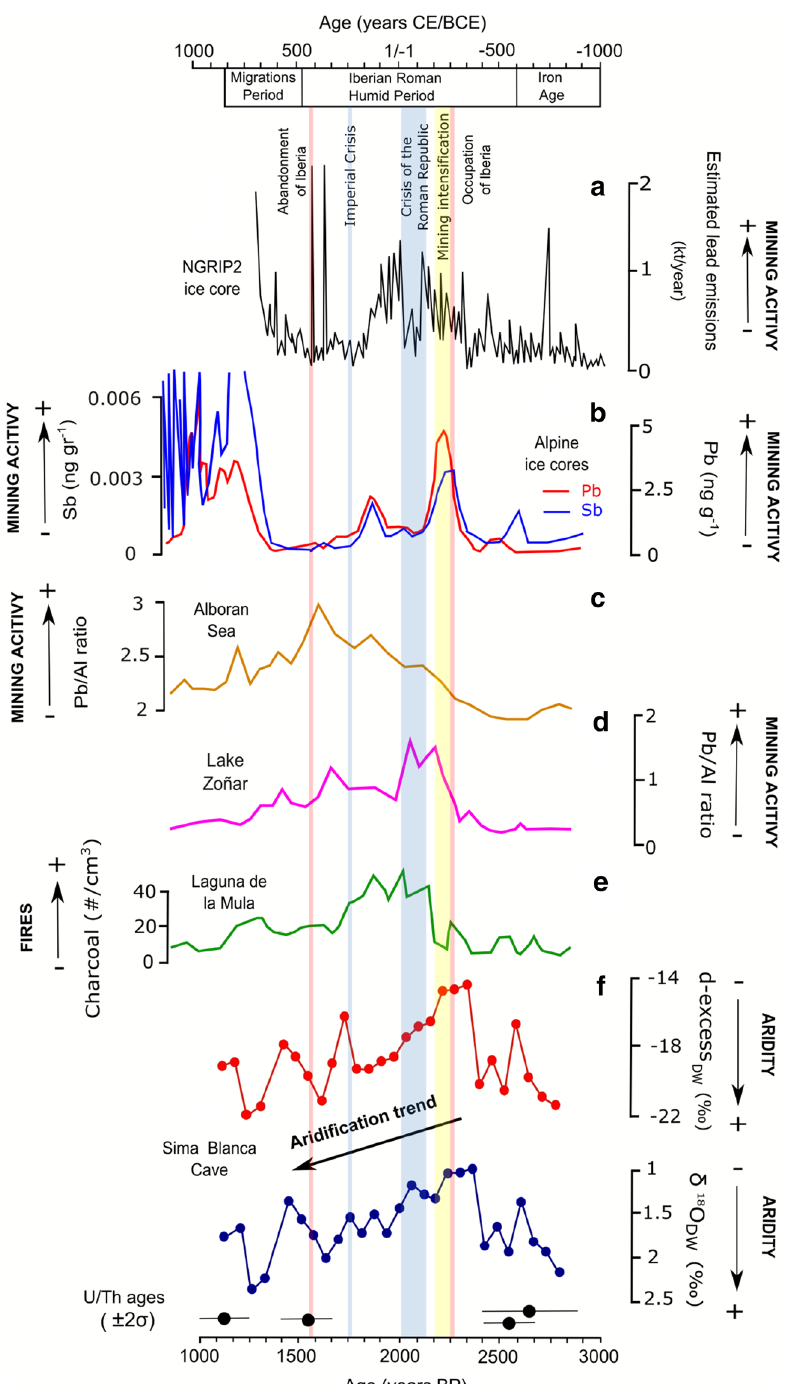
Figure 7. Pollution proxies from 3,000 to 1,000 years BP compared to the Sima Blanca paleo-humidity record: ( a ) Estimation of global lead emissions reconstructed from lead concentration in Greenland ice core NGRIP2 50 ; ( b ) Pb and Sb concentrations in Alpine ice cores 52 ; ( c , d ) Pb/Al ratio in sediments of Lake Zoñar and Alboran Sea cores 33 ; ( e ) Charcoal content in sediments (fragments/cm 3 ) of Laguna de la Mula 36 ; ( f ) Reconstructed d-excess and δ 18 O of evaporated dripwater in Sima Blanca Cave (this study). Major historical events related to the Roman Empire are indicated, including the occupation and abandonment of the Iberian